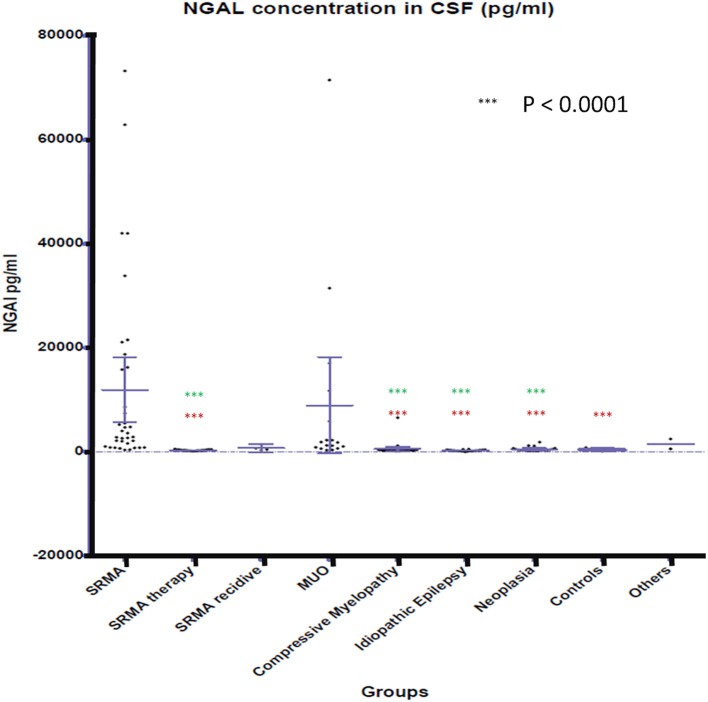
NGAL concentrations in CSF of the different groups. Boxes contain values from the first to the third quartile; lines inside the boxes indicate median values; end of vertical lines show minimum and maximum values; dots represent outliers. Red asterisks (***) represent groups differing significantly (p < 0.0001) from acute SRMA group. Green asterisks (***) represent groups differing significantly from MUO group. NGAL, neutrophil gelatinase-associated lipocalin; SRMA, steroid-responsive meningitis-arteriitis; CSF, cerebrospinal fluid; MUO, meningoencephalitis of unknown origin; IE, idiopathic epilepsy; “SRMA therapy” consisted of dogs under treatment without clinical signs, “SRMA recidive” consisted of dogs with relapse of clinical signs, “Myelopathy” group consisted of dogs with intervertebral disc herniation or compressive spondylomyelopathy, “Neoplasia” included dogs with primary and secondary brain tumors, “Controls” included patients without neurological disorders (healthy and orthopedic), “Others” included various neurological diseases (bacterial meningoencephalitis, idiopathic vestibular syndrome, behavioral abnormalities).